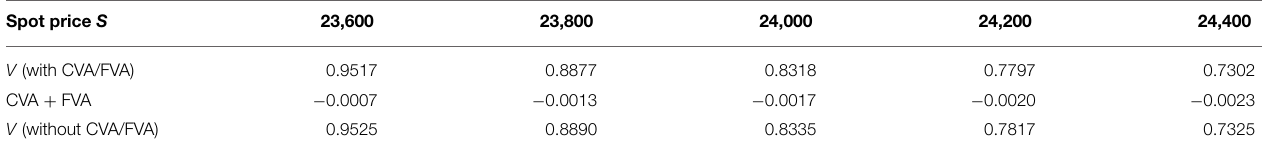
TABLE 15 | Prices of first-touch digital under KoBoL as of 9 January 2015, time to maturity T = 0 . 463 , barrier H = 23 , 500 , risk-free rate r = 0 . 52 % , collateral rate